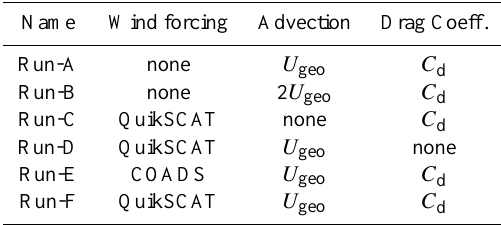
Table 1. Summary of the performed numerical experiments, the relatives names and the